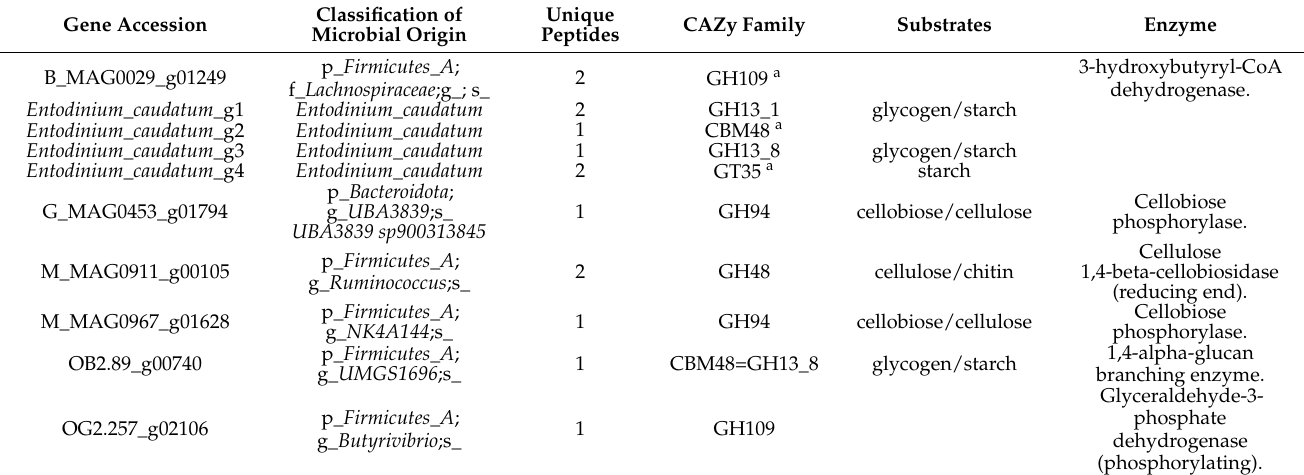
Table 1. The microbe-derived extracellular proteins with carbohydrate-active enzyme-related